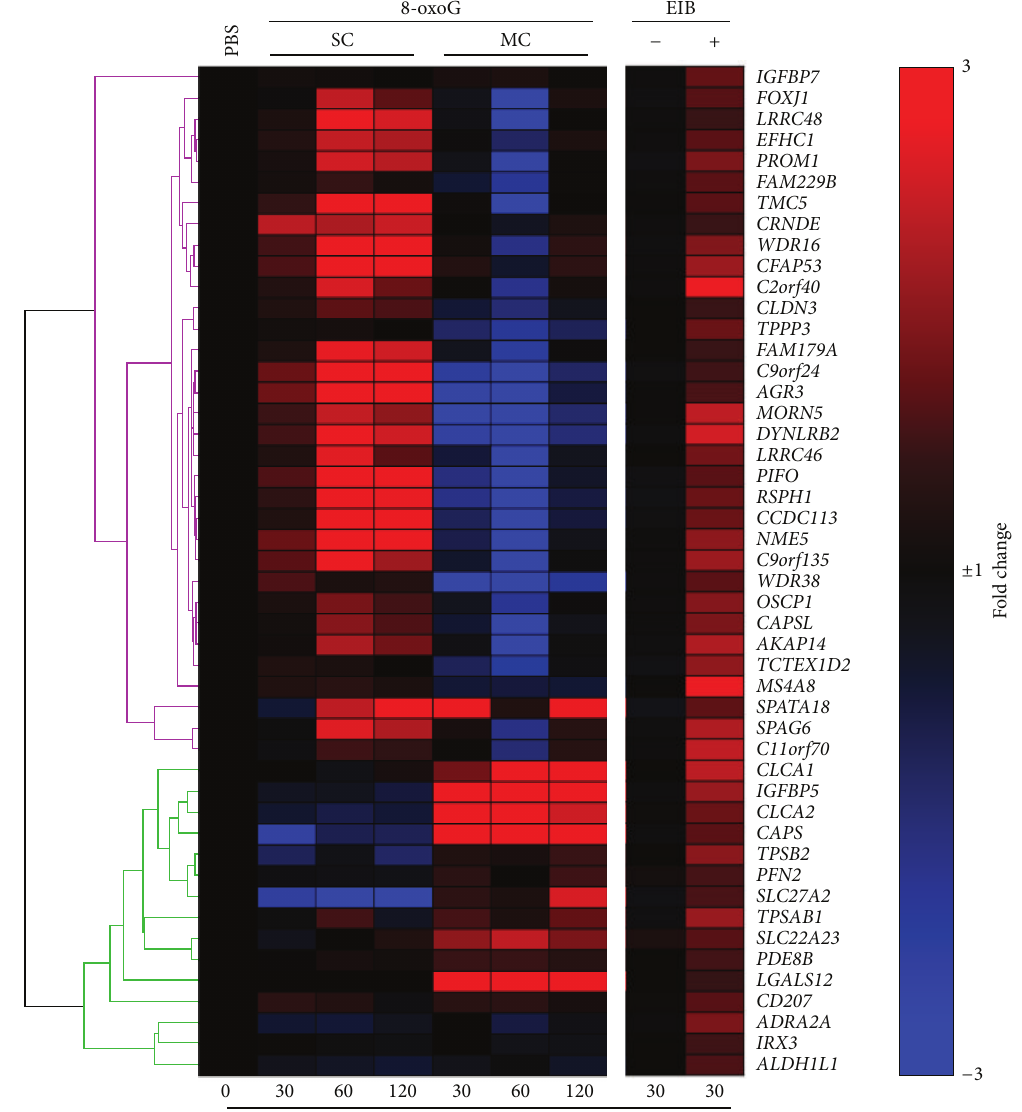
Figure 1: Comparative gene expression between 8-oxoG challenged- and intensive exercise-exposed airways. The clustered heat map was constructed using the list of the most upregulated genes in airway epithelial cells from EIB positive (EIB + ) individuals after 30 minutes of intensive exercise, as described in Hallstrand et al. [22]. This list of genes was compared to a list of the same genes from lungs challenged once (SC) or multiple times (MC). Top ranked gene list was obtained using Gene Expression Omnibus (GEO)’s built-in application GEO2R (http://www.ncbi.nlm.nih.gov/geo/geo2r/) and Hallstrand et al. GEO deposited dataset (GSE13785). Hierarchically clustered heat map was generated using GENE-E (Broad Institute,